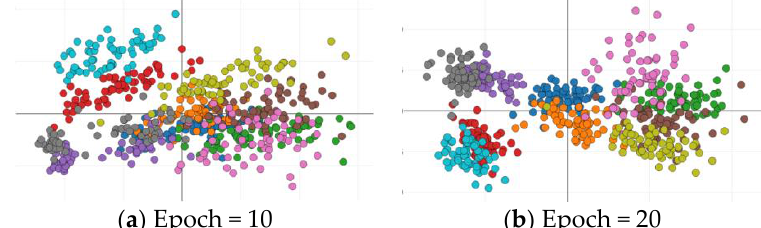
Figure 7. The distribution of feature points from the multi-classifier of GANs in different epochs (128 × 128 input): ( a ) Epoch = 20 and ( b ) Epoch = 40. Different colors represent different categories. When the epoch is 20, the features from the output of low level layers of the discriminator have better separability.